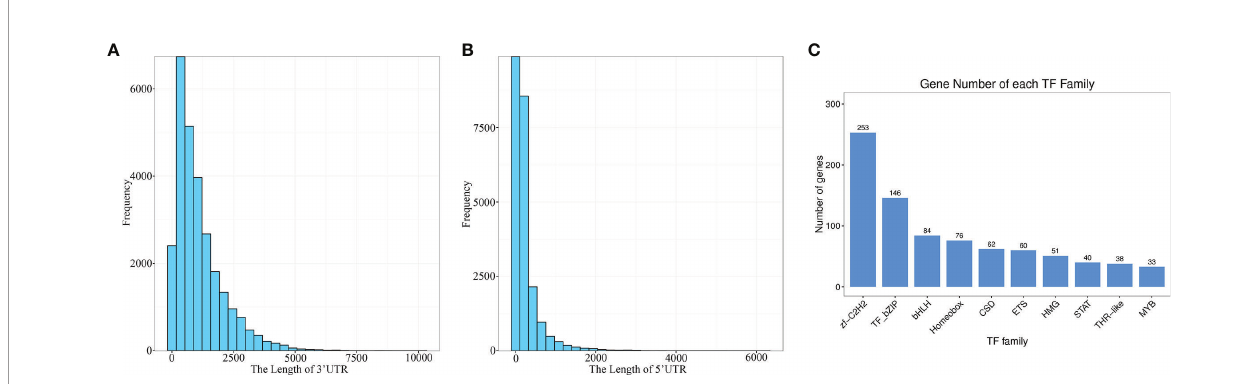
FIGURE 5 | Prediction of the coding sequences and transcription factors. (A) The length of 3 ’ UTR. (B) The length of 5 ’ UTR. (C) TF family distribution (top 10).